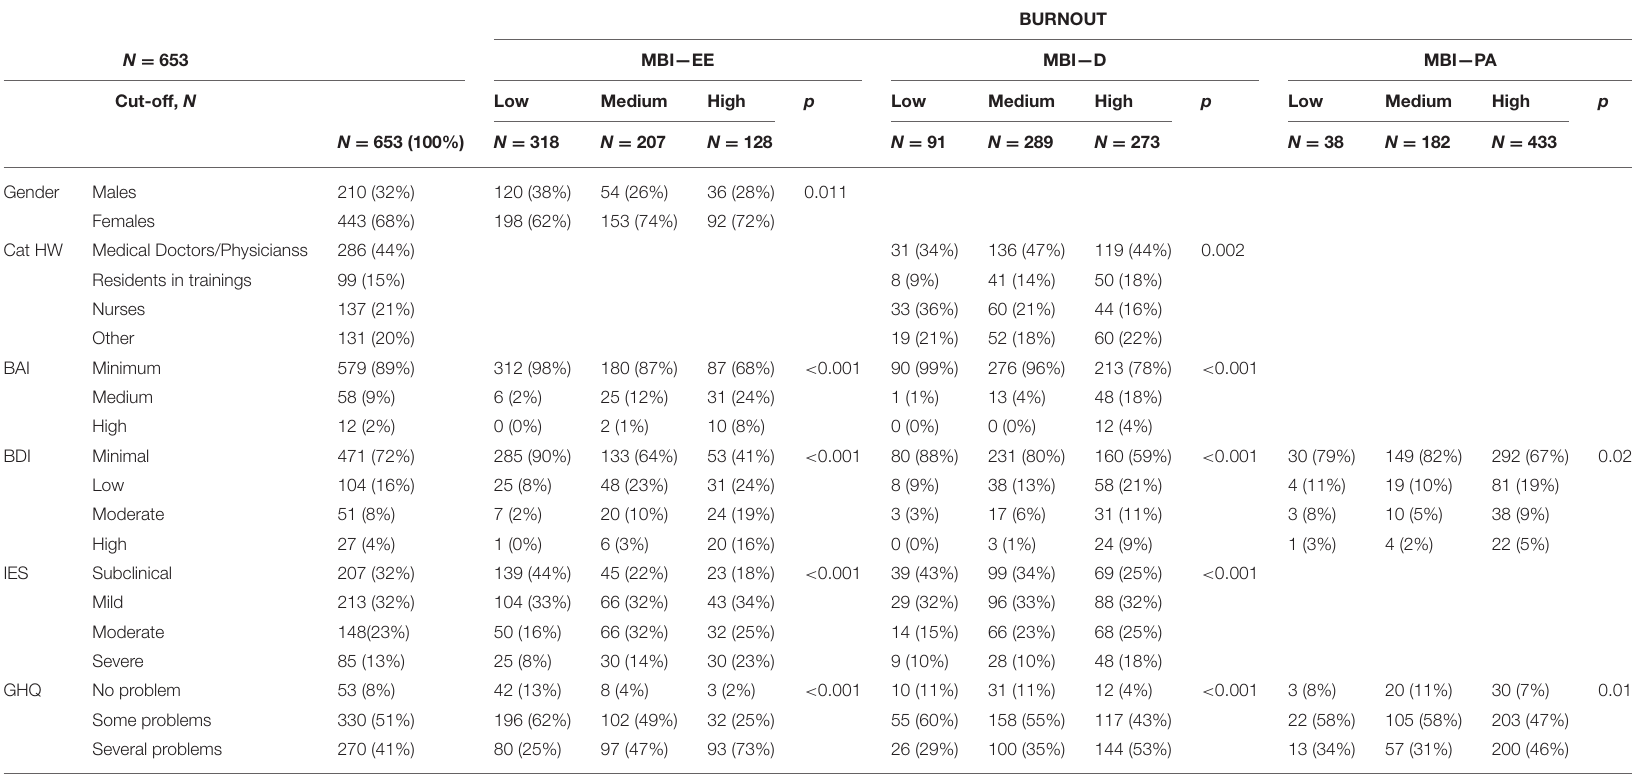
TABLE 2 | Focus on burnout as measured with the Maslach Burnout Inventory (MBI) scale: analysis of categorical socio-demographic features and test results ( n , %